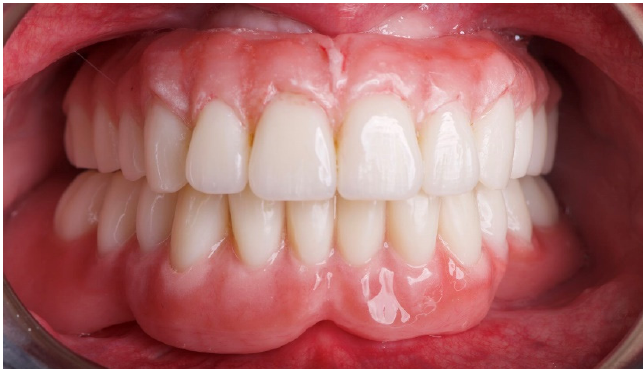
Figure 23. Clinical view of the maxillary definitive prosthesis one year after its delivery.